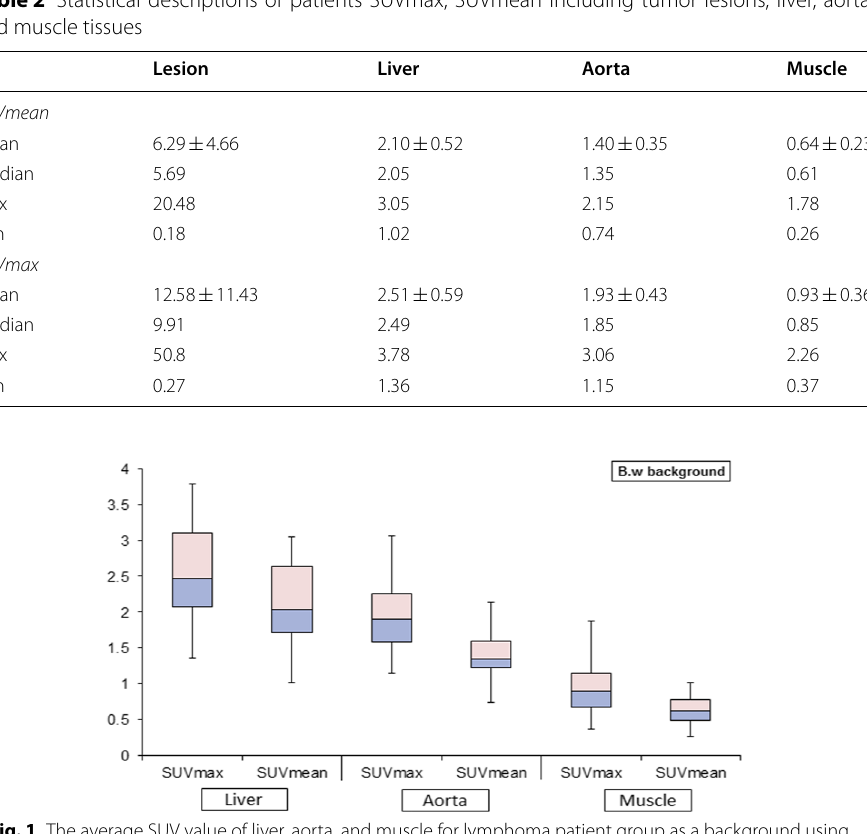
Table 3 Statistical descriptions of normalization of lesion with respect to different backgrounds Lesion/Liver